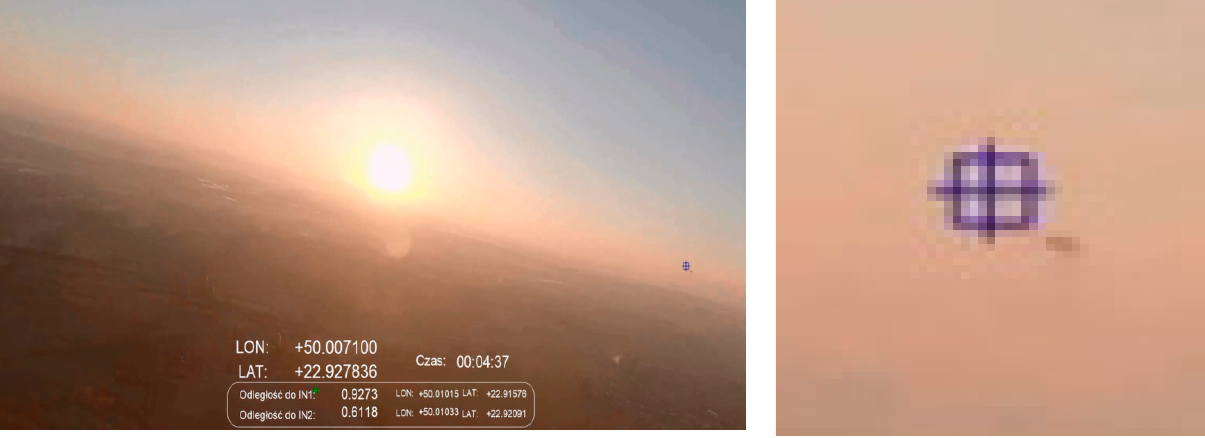
Figure 12. Scenario related to Figure 5B; sunset, altitude ~500 m, distance to intruder: 927 m.